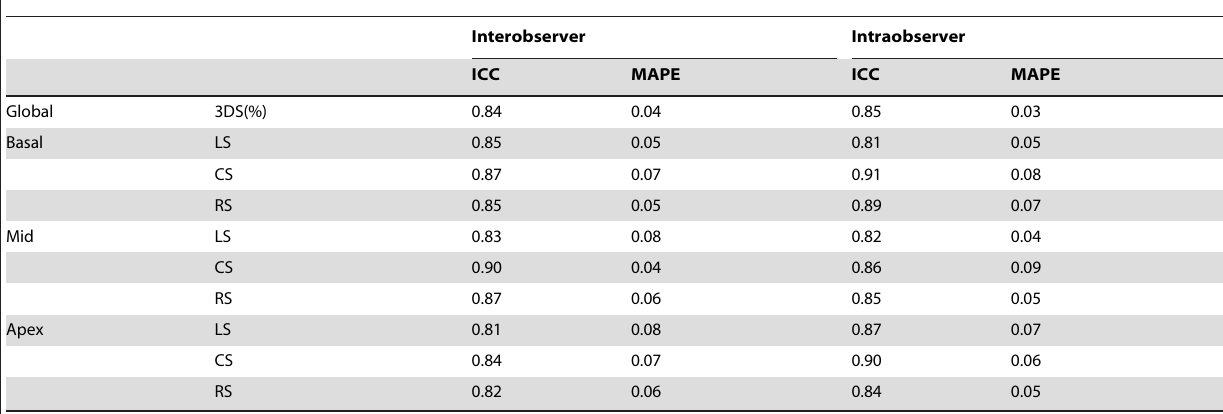
Table 5. Reproducibility of interobserver and intraobserver by 3D